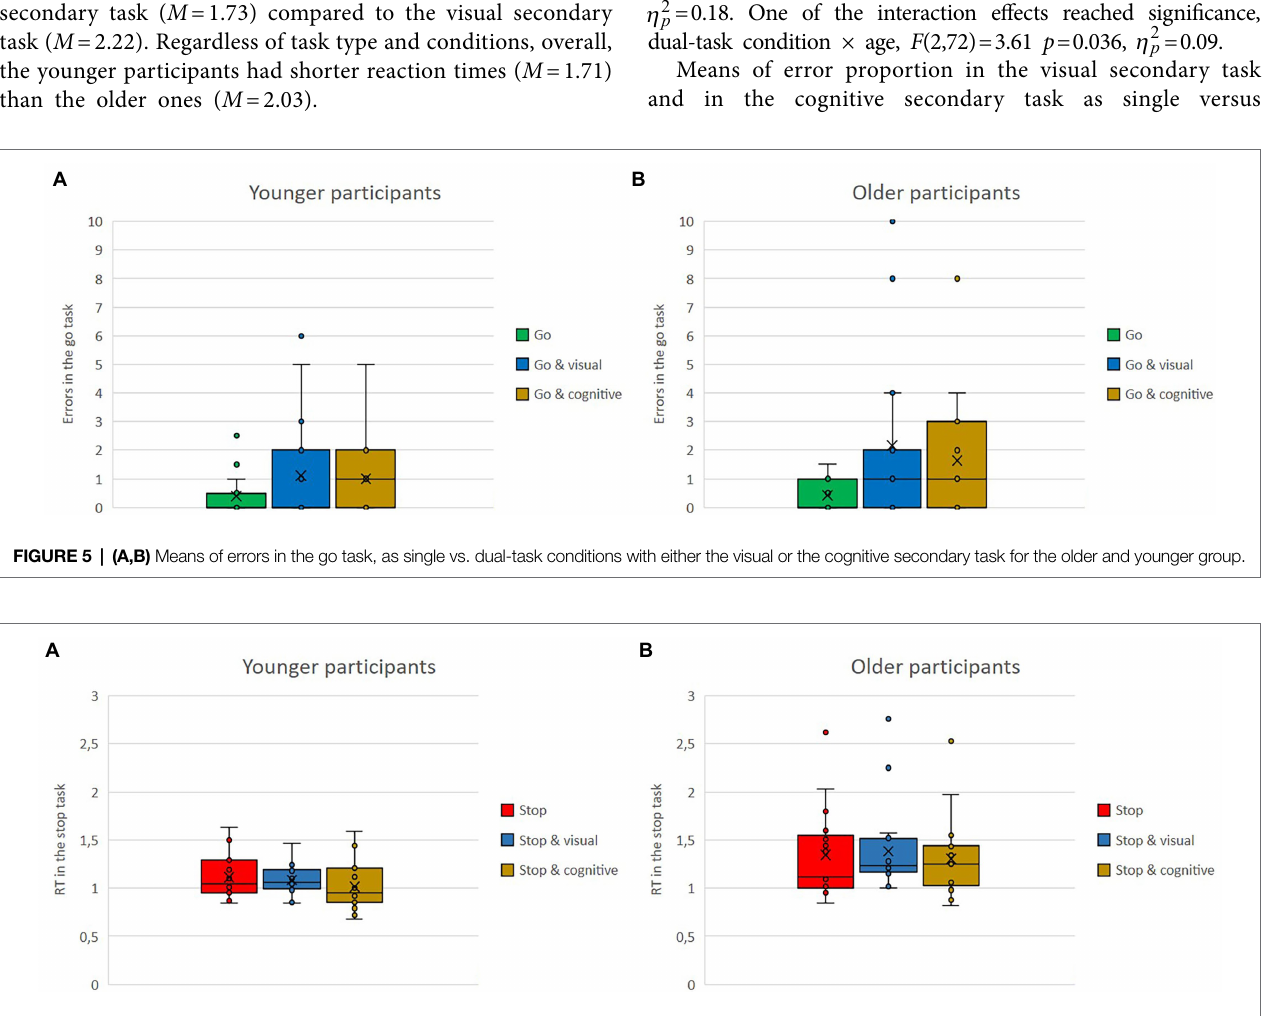
FIGURE 6 | (A,B) Means of response time in seconds in the stop task, as single vs. dual-task conditions with either the visual or the cognitive secondary task for the older and the younger group.